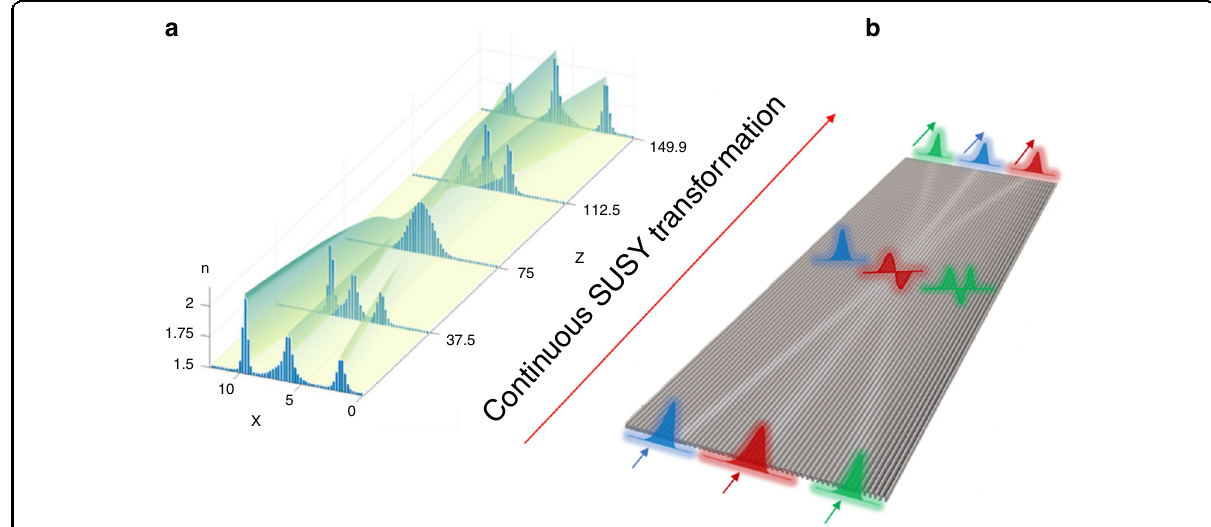
Fig. 1 Continuous SUSY transformation optics and its demonstration on a Si chip. a Two dimensional refractive index distribution n(x, z) designed by SUSY transformation (unit: um); b GRIN metamaterial designed to substantiate n(x, z), where different optical states (blue, red, green) with different propagation constants can propagate with spatial characteristics and directions dictated by the SUSY